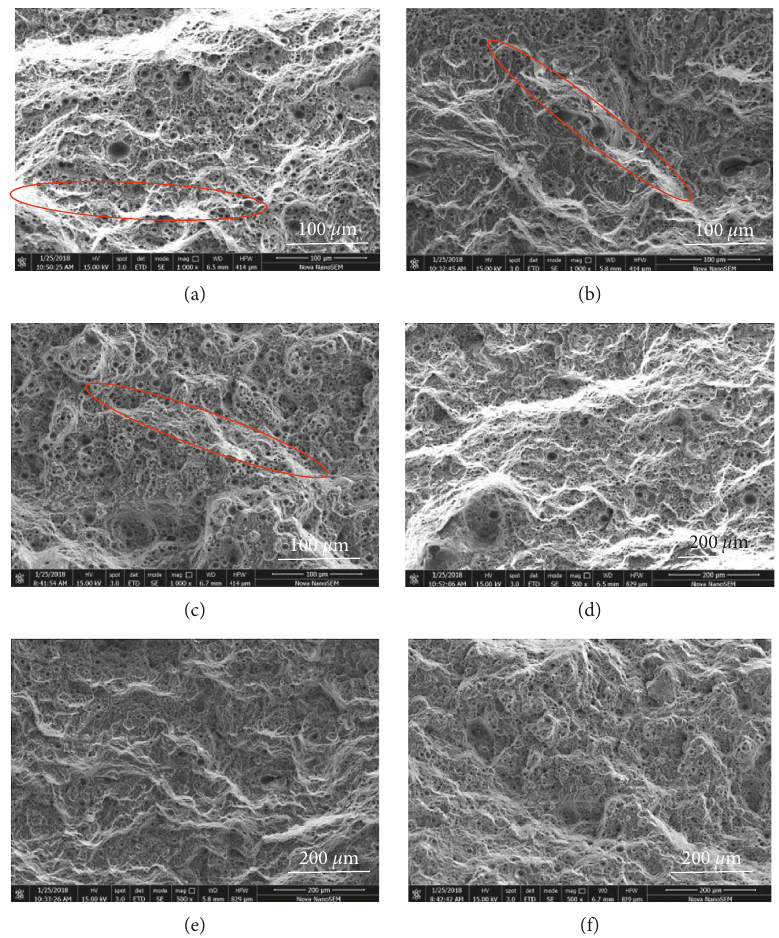
Figure 12: The typical fracture images of SLM-processed AlSi10Mg samples at (a, d) chessboard scanning, preheating temperature 80 ° C; (b, e) chessboard scanning, preheating temperature 120 ° C; and (c, f) chessboard scanning, preheating temperature 160 °